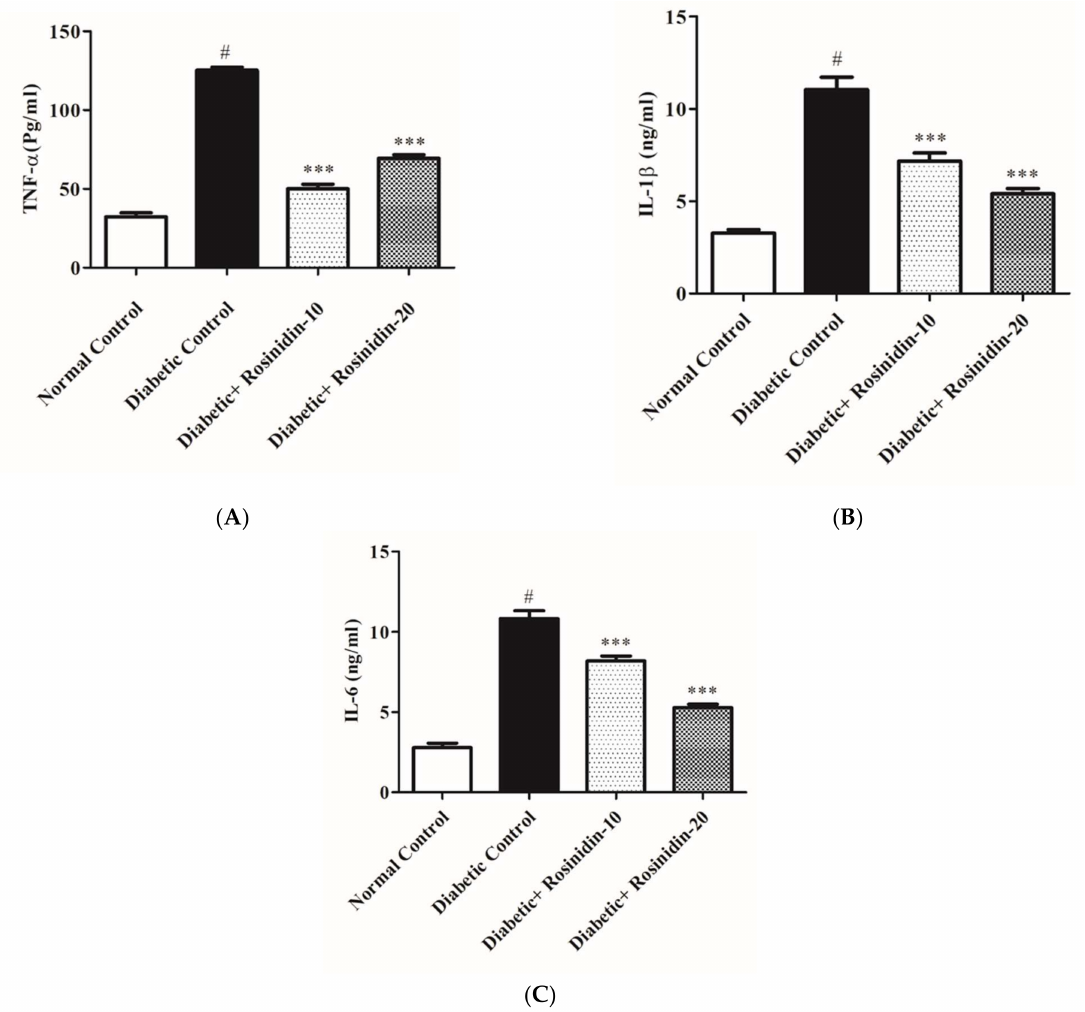
Figure 8. ( A ) Effect of rosinidin on TNF- α against that of STZ-induced diabetic rats ( n = 6). Values are expressed as mean ± SEM. # p < 0.05, normal control vs. diabetic control; *** p < 0.001, diabetic control vs. rosinidin-10, rosinidin-20. ( B ) Effect of rosinidin on IL-1 β against that of STZ-induced diabetic rats ( n = 6). Values are expressed as mean ± SEM. # p < 0.05, normal control vs. diabetic control; *** p < 0.001, diabetic control vs. rosinidin-10, rosinidin-20. ( C ) Effect of rosinidin on IL-6 against that of STZ-induced diabetic rats ( n = 6). Values are expressed as mean ± SEM. # p < 0.05, normal control vs. diabetic control; *** p < 0.001, diabetic control vs. rosinidin-10,